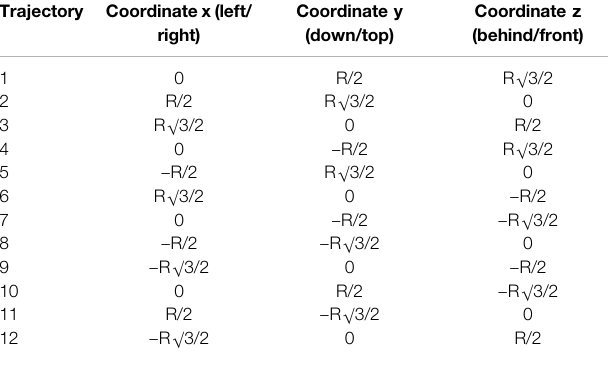
TABLE 1 | Coordinates of the twelve virtual sound sources (where R (cid:1) 1.2 m). Trajectory Coordinate x(left/ Coordinate y Coordinate z right) (down/top)